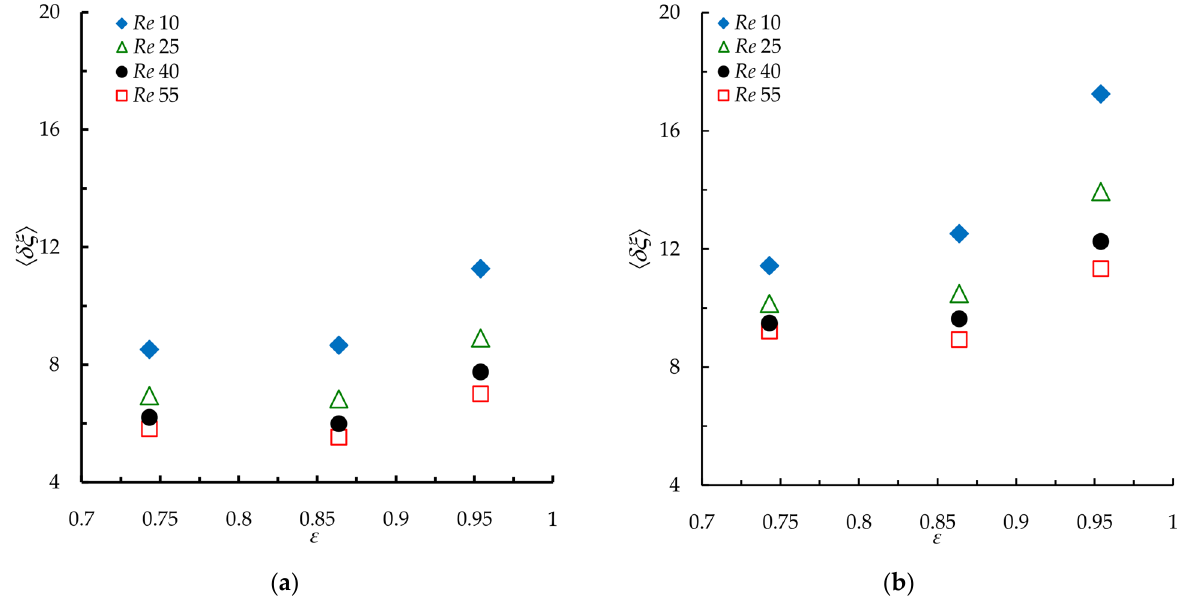
Figure 16. The porosity effect on the friction factor ratio averaged over one period of pulsation for different duty cycles: ( a ) ψ = 0.25, ( A / D s ) St = 0.268. ( b ) ψ = 0.5, ( A / D s ) St = 0.268.